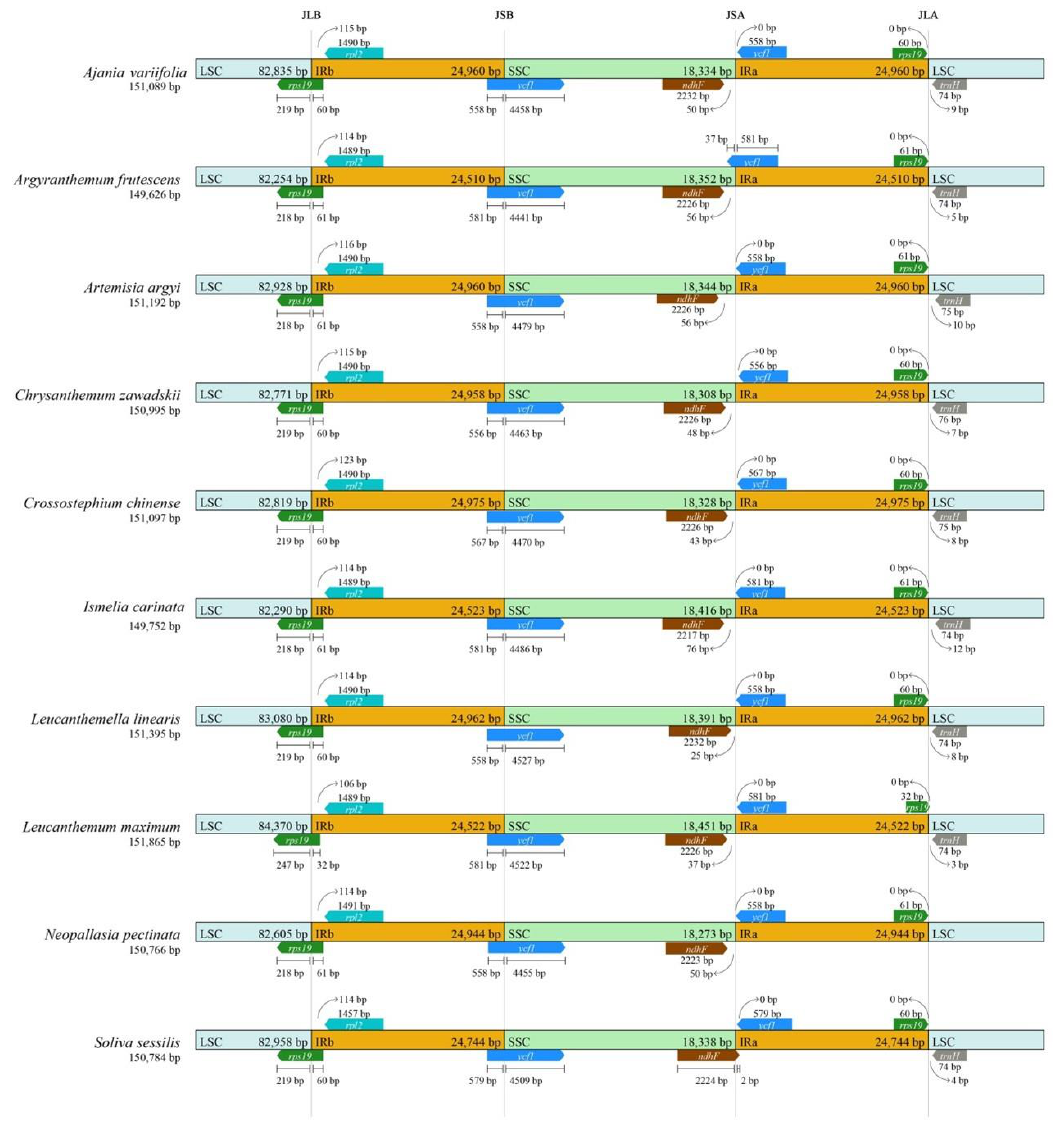
Figure 4. The junctions of IR/SC comparison among 10 species in the tribe of Anthemideae. Arrows indicated the distance of the gene to the junctions, and the I-shaped line represented the length of the gene on either side of the junctions.